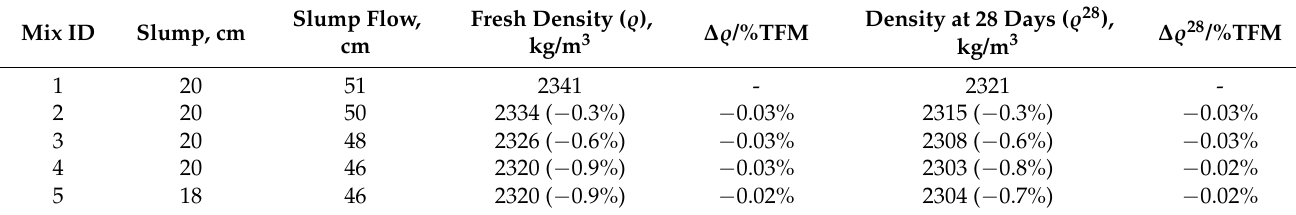
Table 5. Fresh and physico-mechanical properties of concretes.